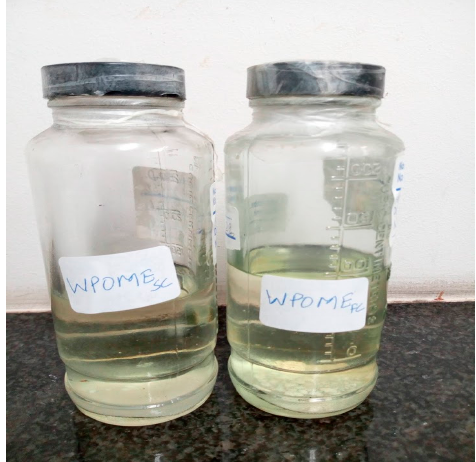
Figure 3. Picture of WPOME SC and WPOME FC samples.